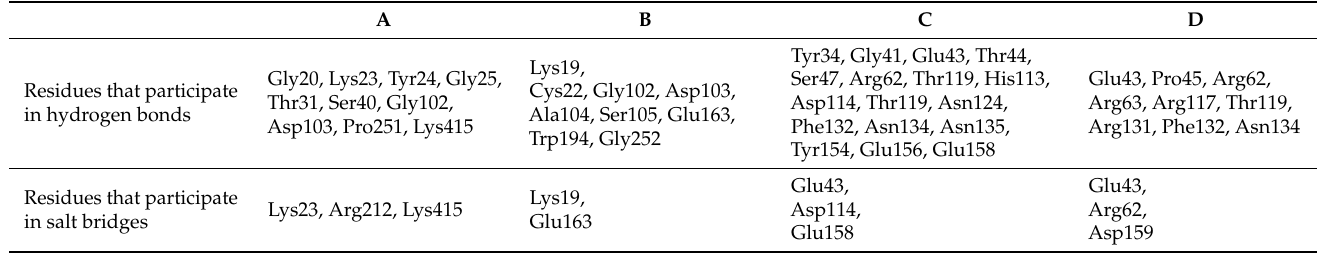
Table 2. List of At SBP1 and At SAH7 residues that participate in the formation of hydrogen bonds and salt bridges after the molecular docking experiment and after the molecular dynamics simula- tion. (A) At SBP1 (resulting complex of the docking experiment), (B) At SBP1 (last frame of the MD simulation), (C) At SAH7 (resulting complex of the docking experiment), (D) At SAH7 (last frame of the MD